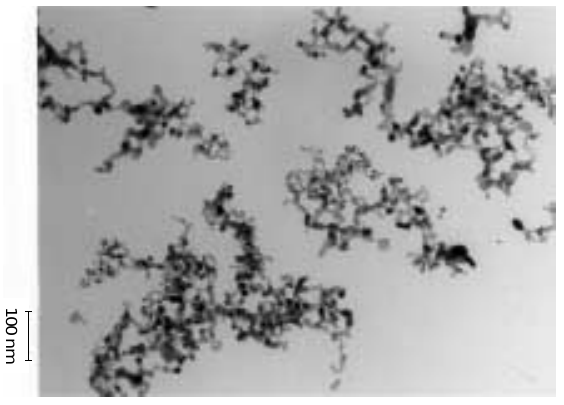
Fig. 16 TEM image of EP Zirconium Dioxide PH with a BET of 74 m 2